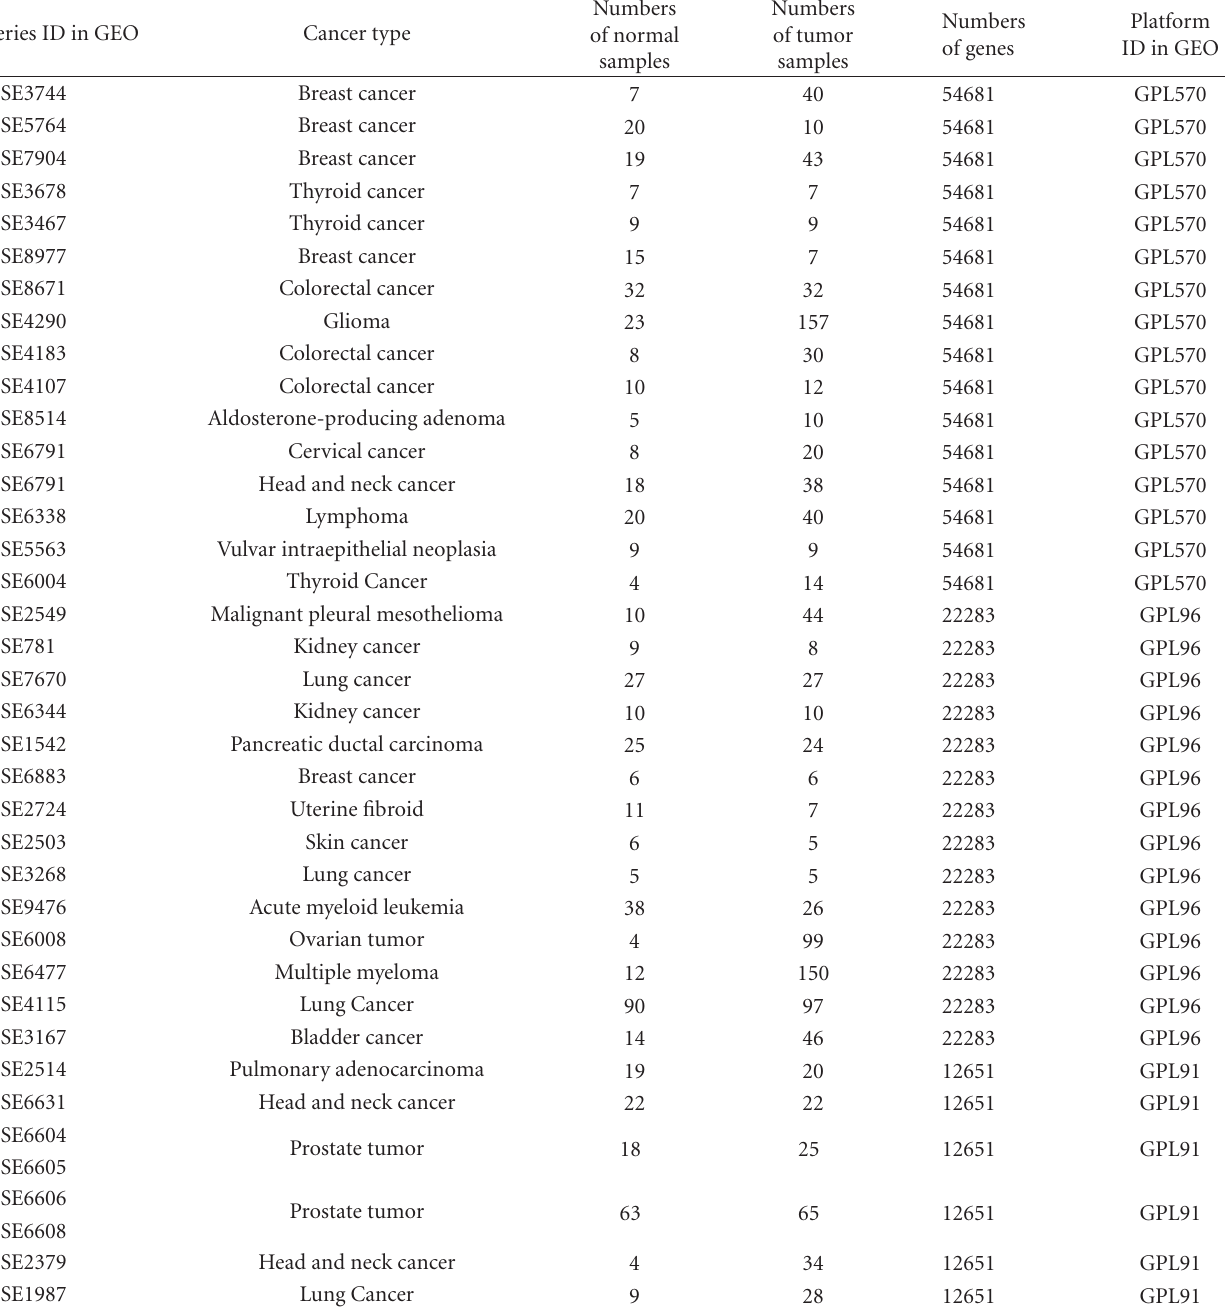
Table 1: List of 36 microarray